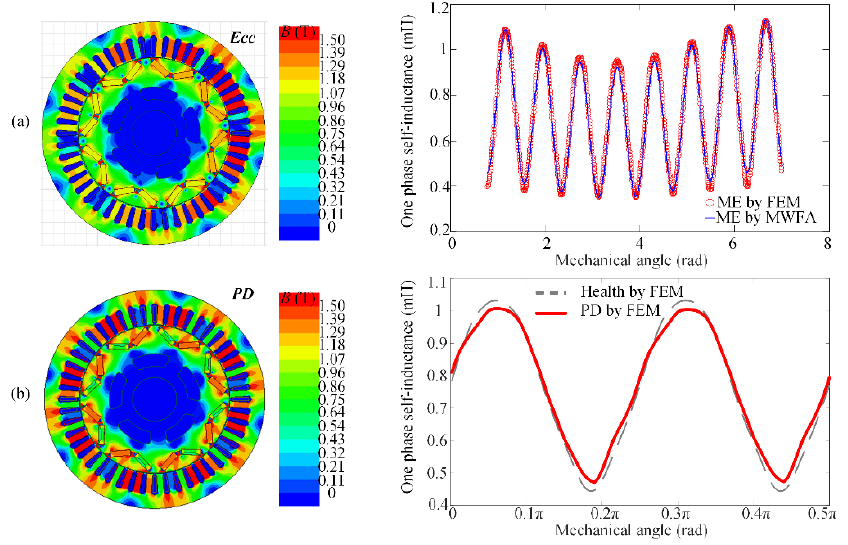
Figure 9. Variation in stator inductances due to ( a ) ME and ( b ) PD. Last but not least, the load torque oscillation produced by shaft misalignments in- volves nonlinear dynamics and it cannot be simulated by single frequency fluctuation.